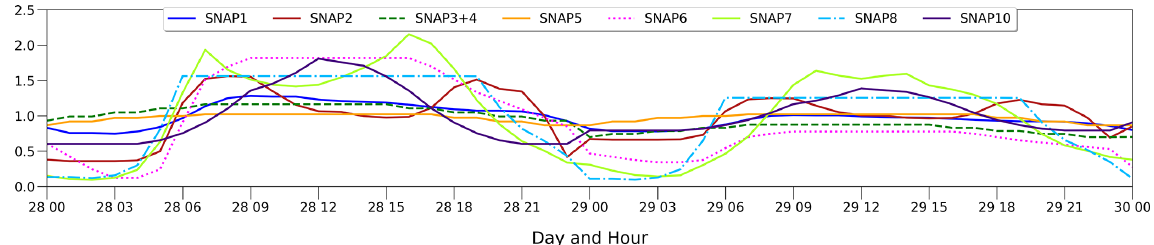
Figure 4. Temporal profile of SNAP categories over Friday (28 June) and Saturday (29 June), showing a variation in diurnal shape for the different sectors and over the 2d. The time is indicated as local time or UTC + 2.